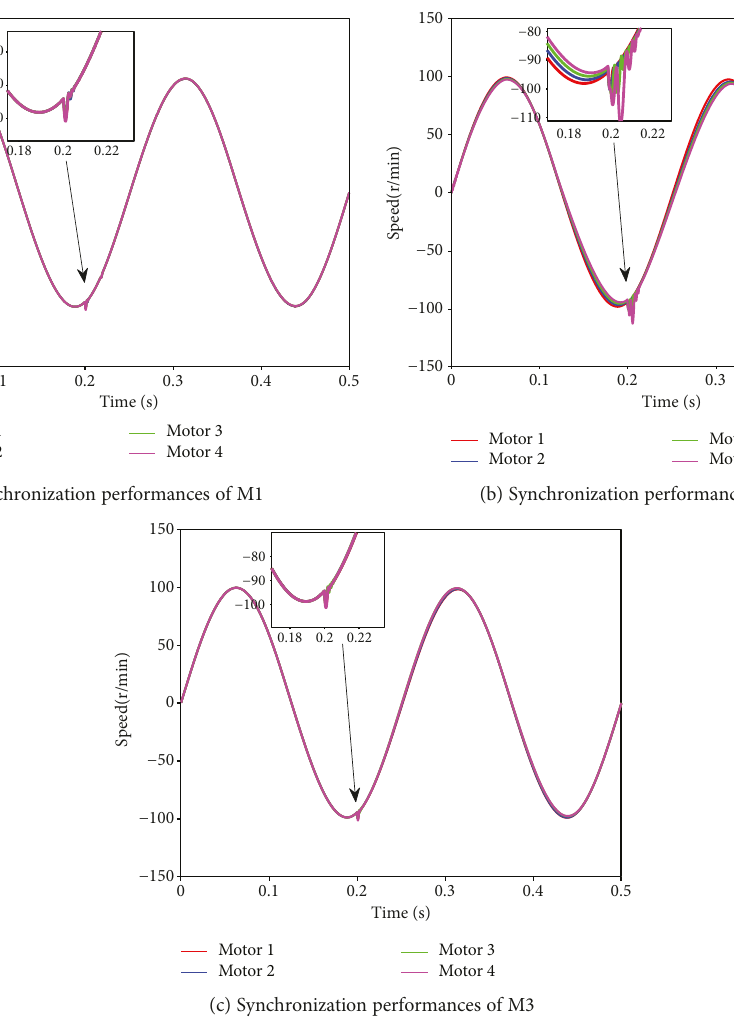
Figure 10: Speed synchronization and tracking